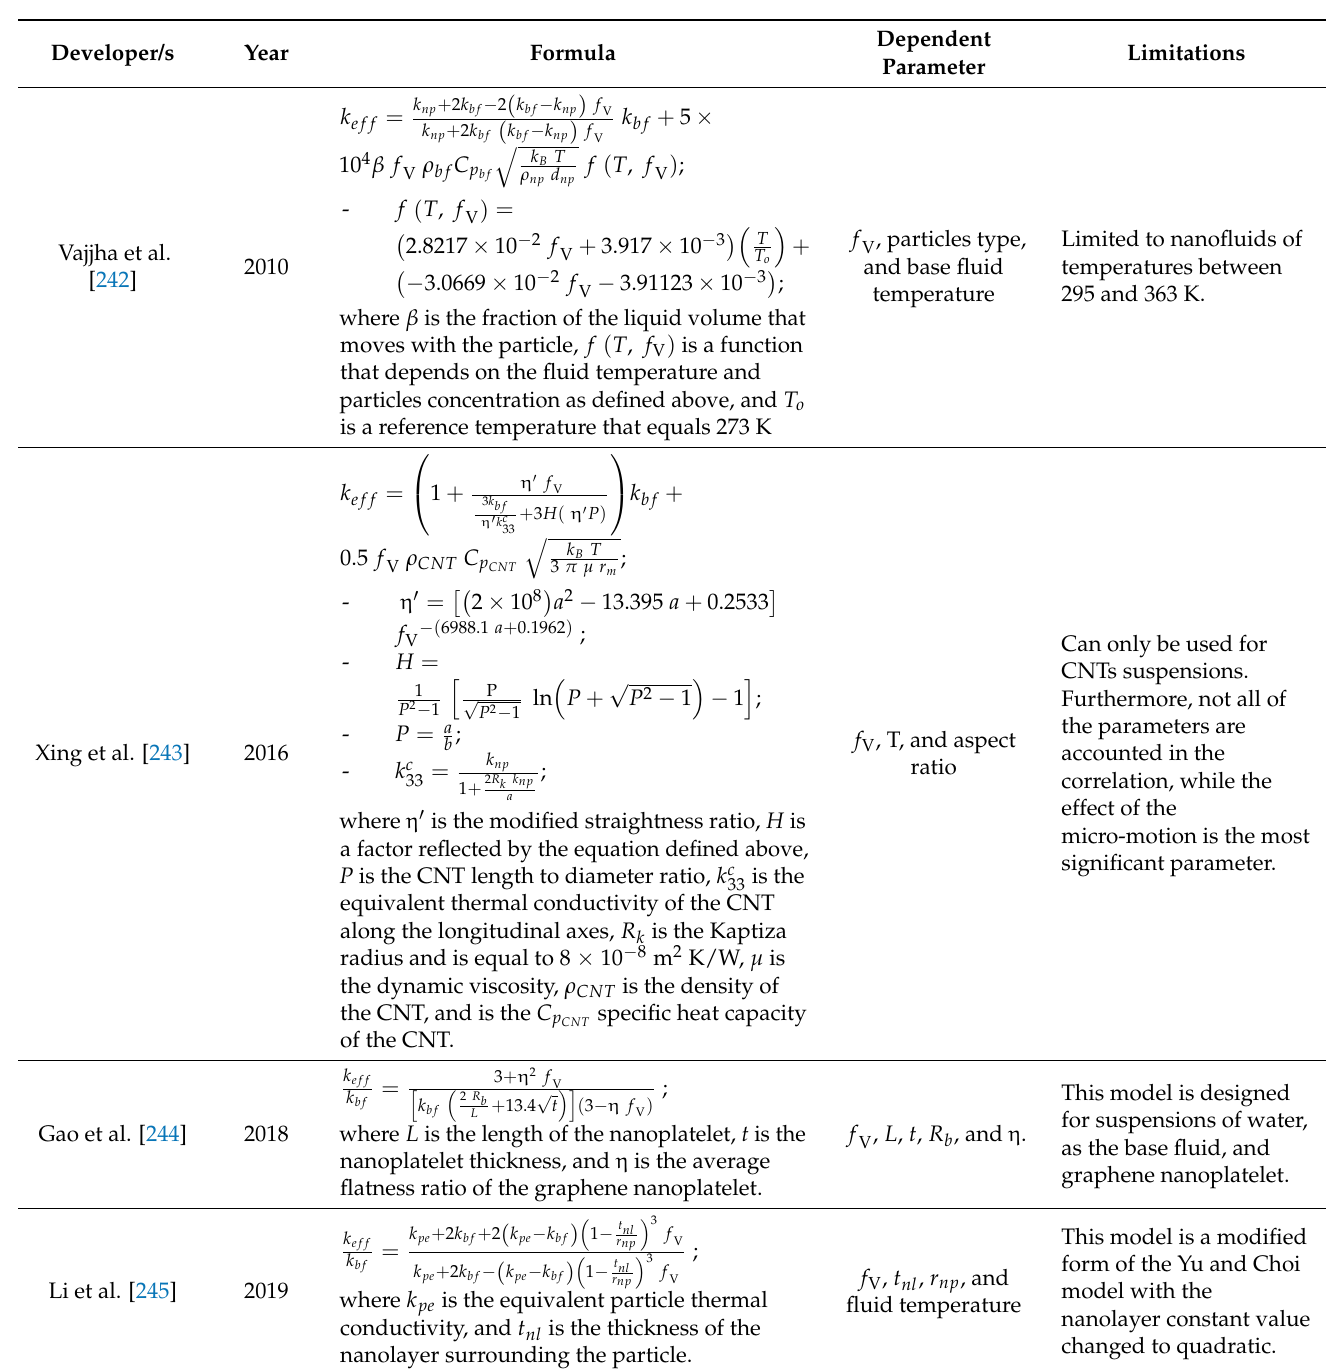
Dependent Parameter